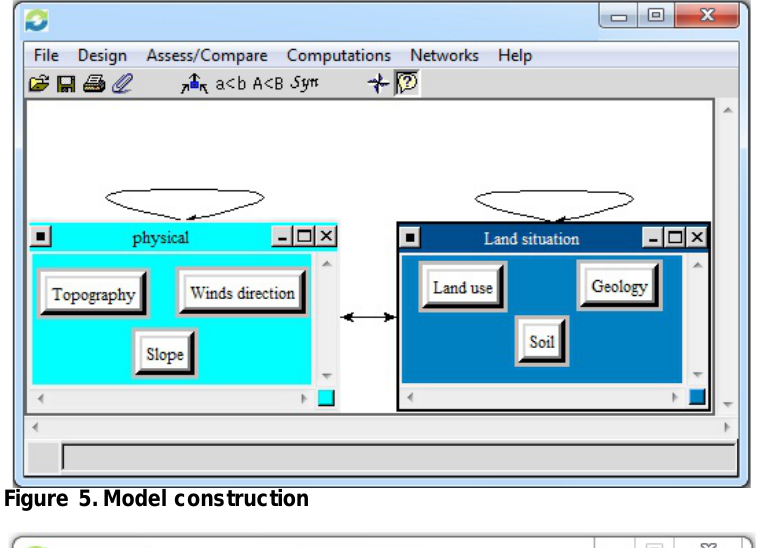
Figure 5. Model construction